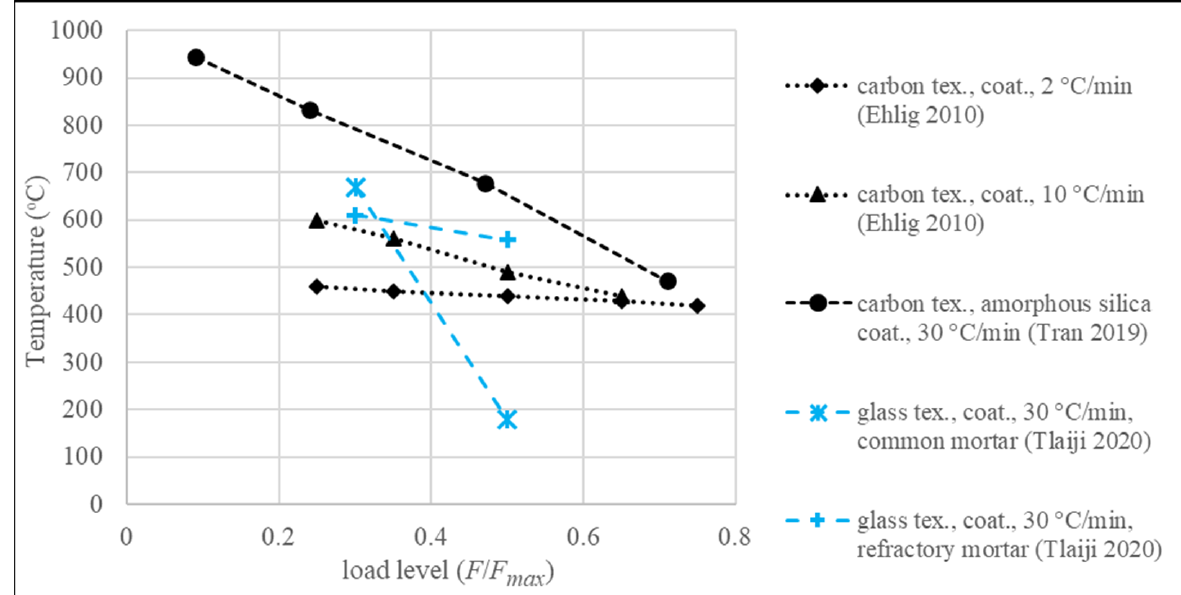
Figure 2. Failure temperatures against tensile load level for TRC specimens heated at constant load.